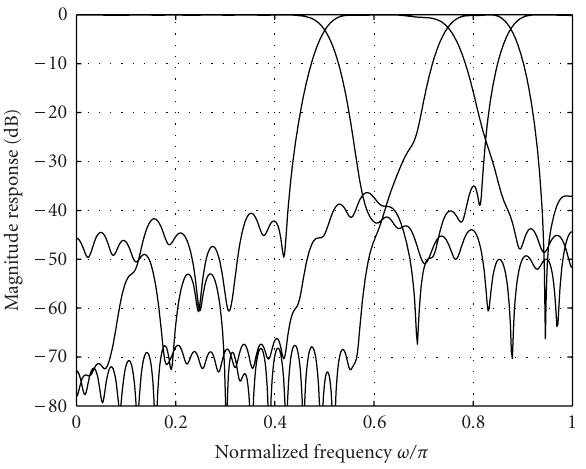
Figure 8: Magnitude responses of the transmitting filters (with fre- quency criteria).